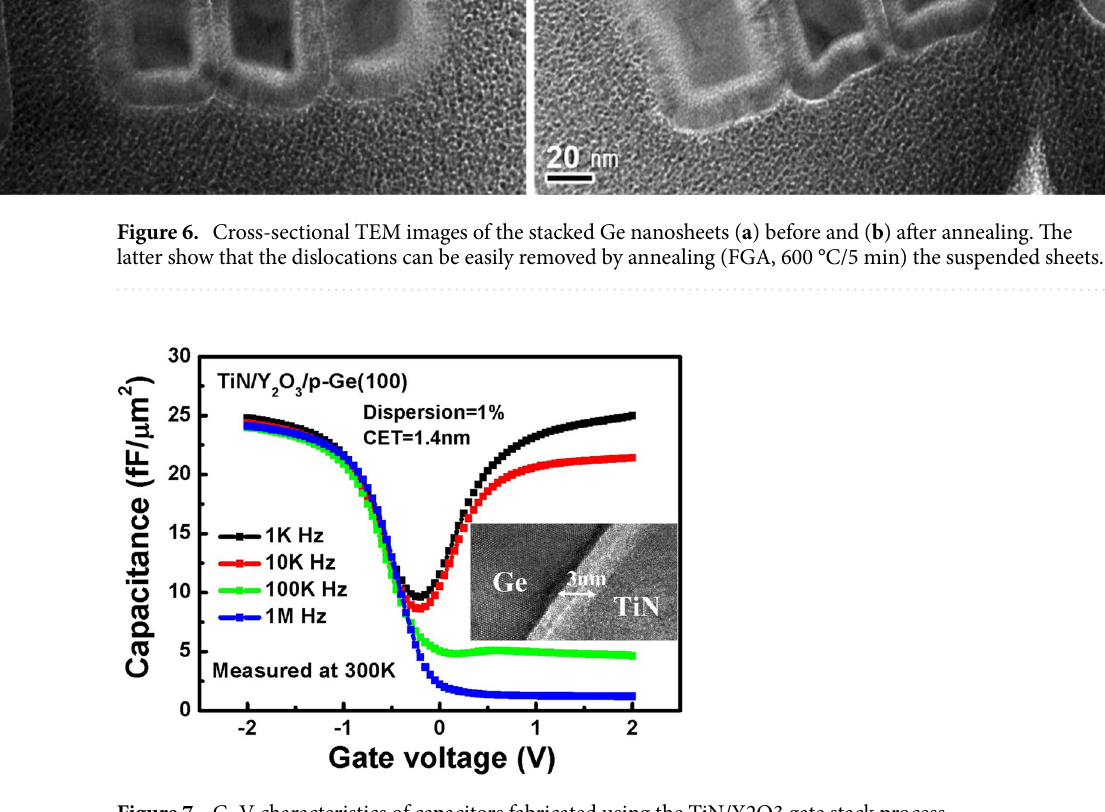
Figure 7. C–V characteristics of capacitors fabricated using the TiN/Y2O3 gate stack process.